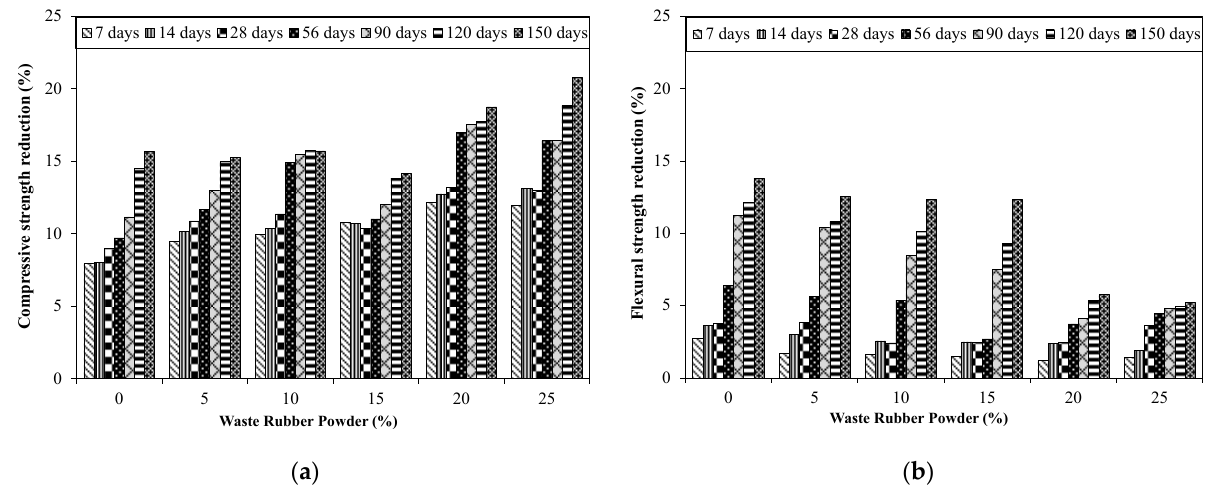
Figure 16. Compressive and flexural strength results of specimens incorporating RW exposed to ASR conditions. ( a ) Compressive strength; ( b ) Flexural strength.